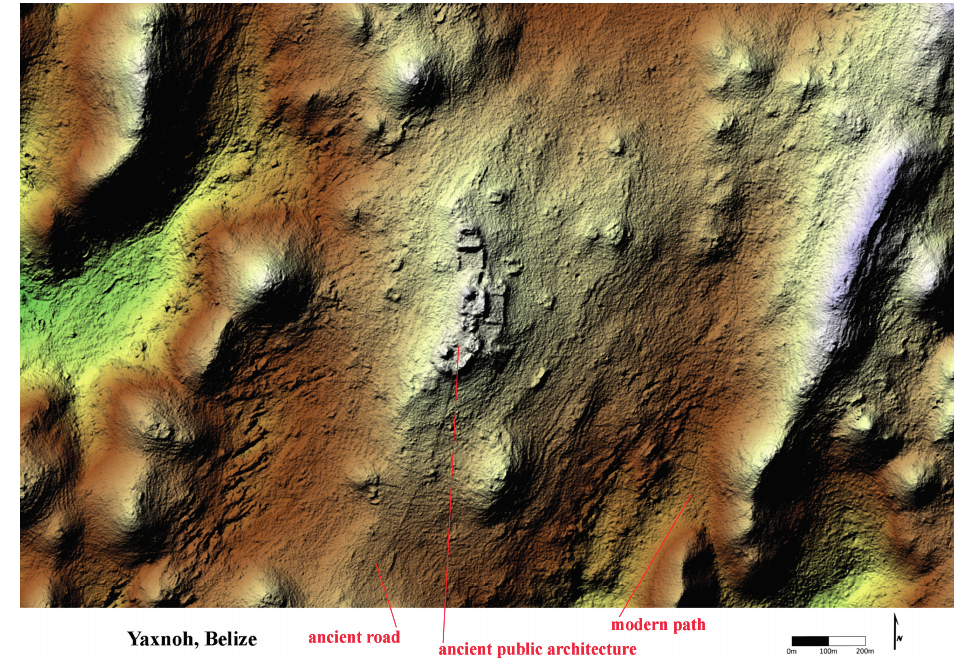
Figure 8. 2.5D LiDAR bare earth rendering of the newly-found site of Yaxnoh,